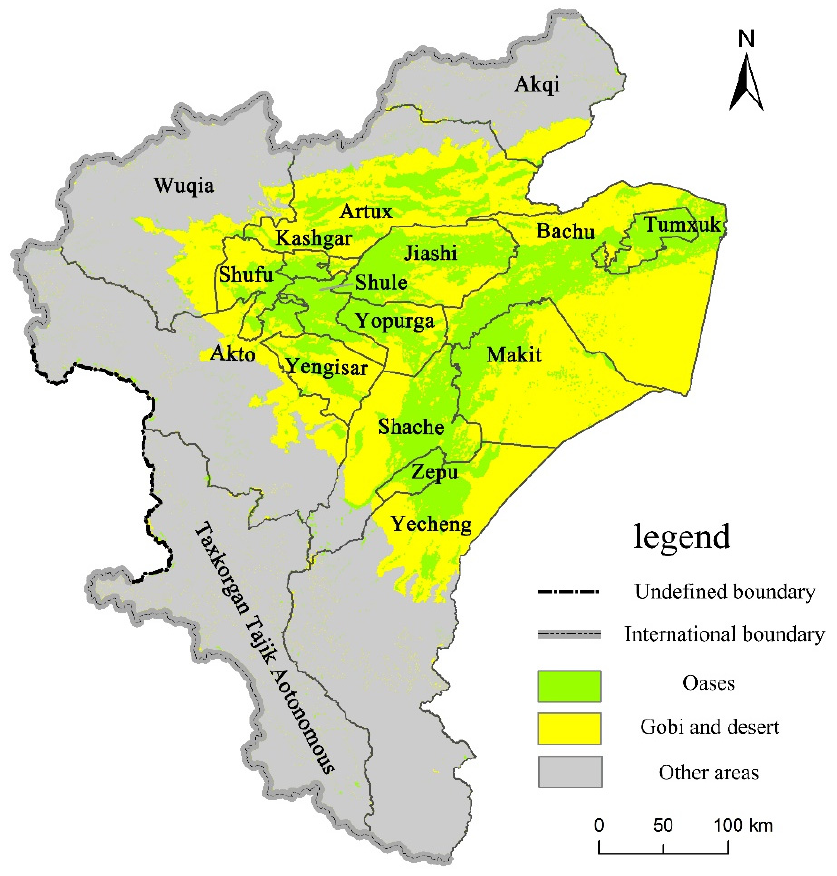
Figure 13. The distribution of oases and deserts in KMA.